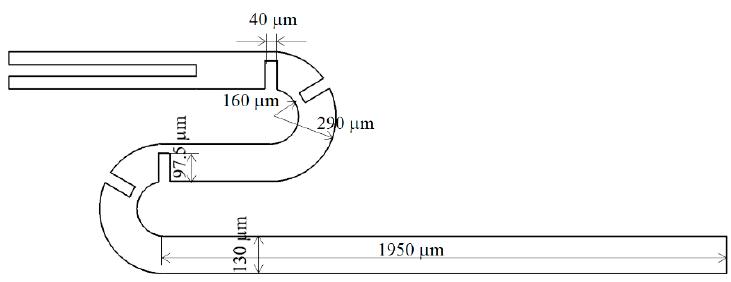
Figure 2. Diagram of a micro-channel experimented by Tsai et al. [25].